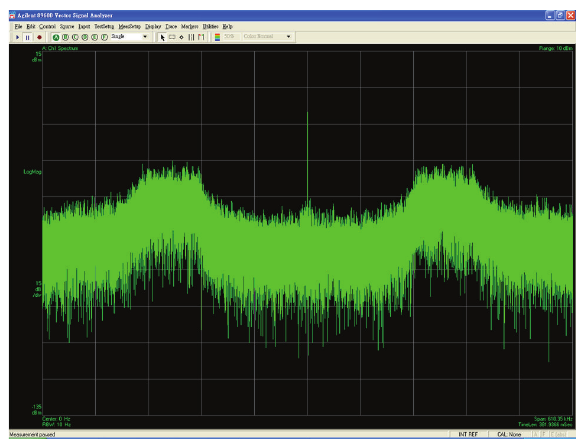
Figure 13: Real transmitting spectrum of the HD radio FM imple- mentation.